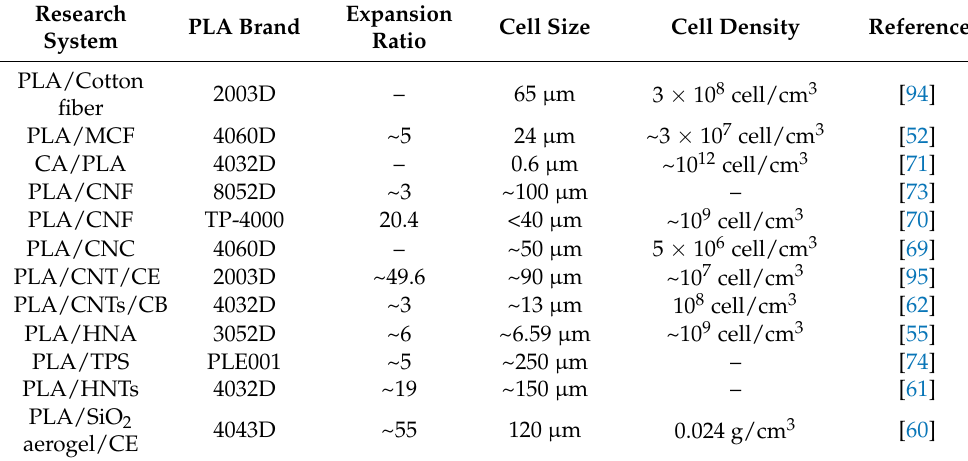
Table 3. Study on modification of PLA foam by fillers in recent three